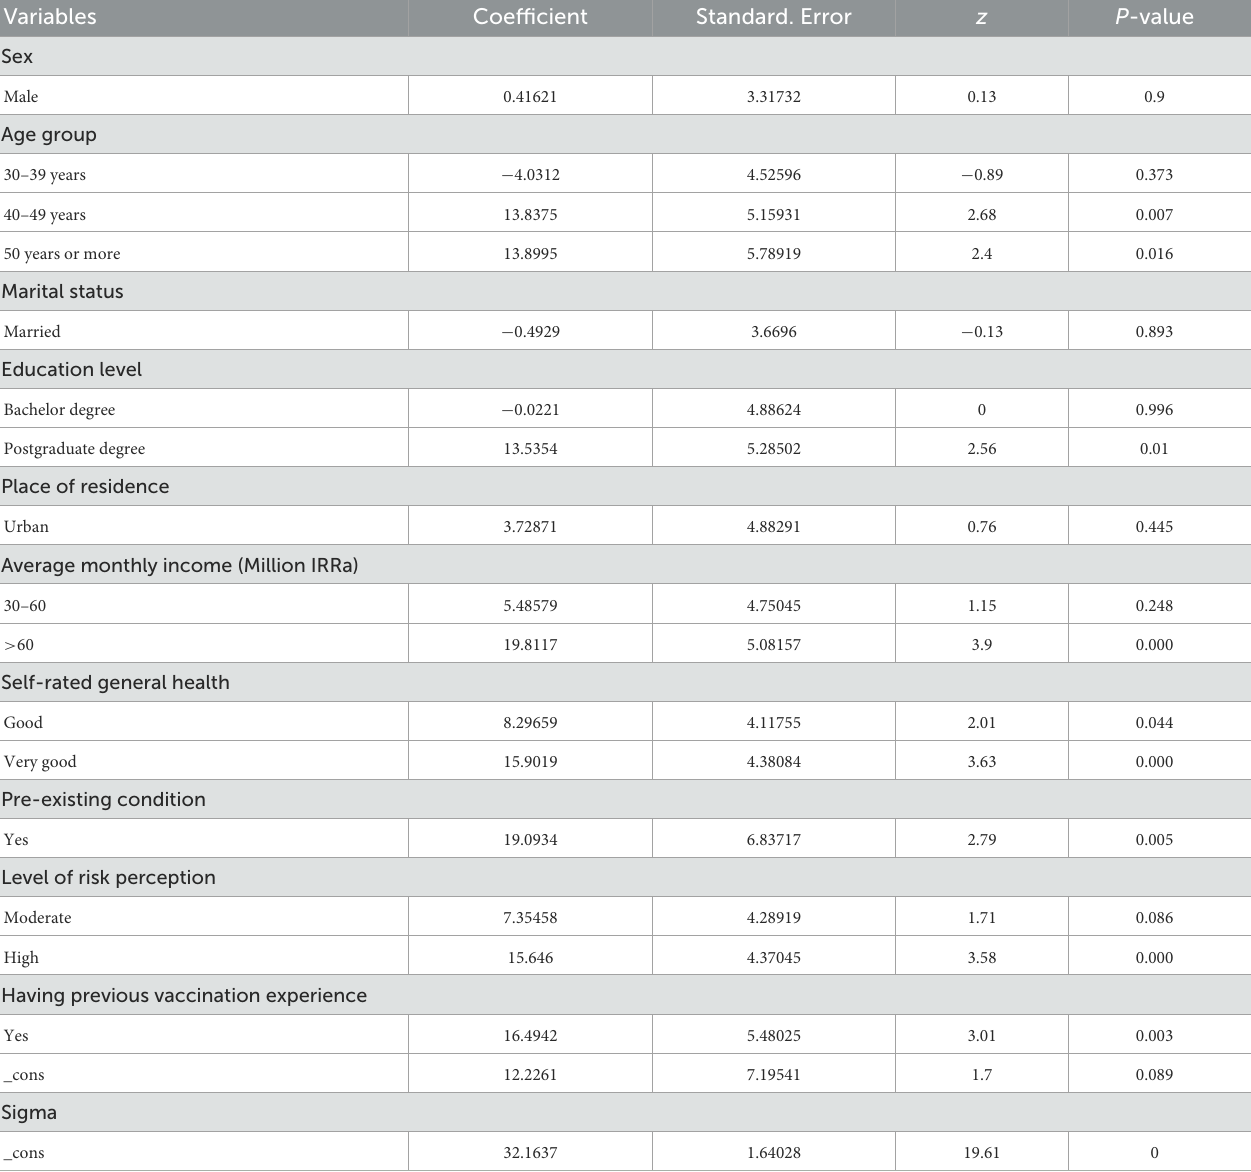
TABLE 2 The effect of explanatory variables on the WTP of individuals for COVID19 vaccine.